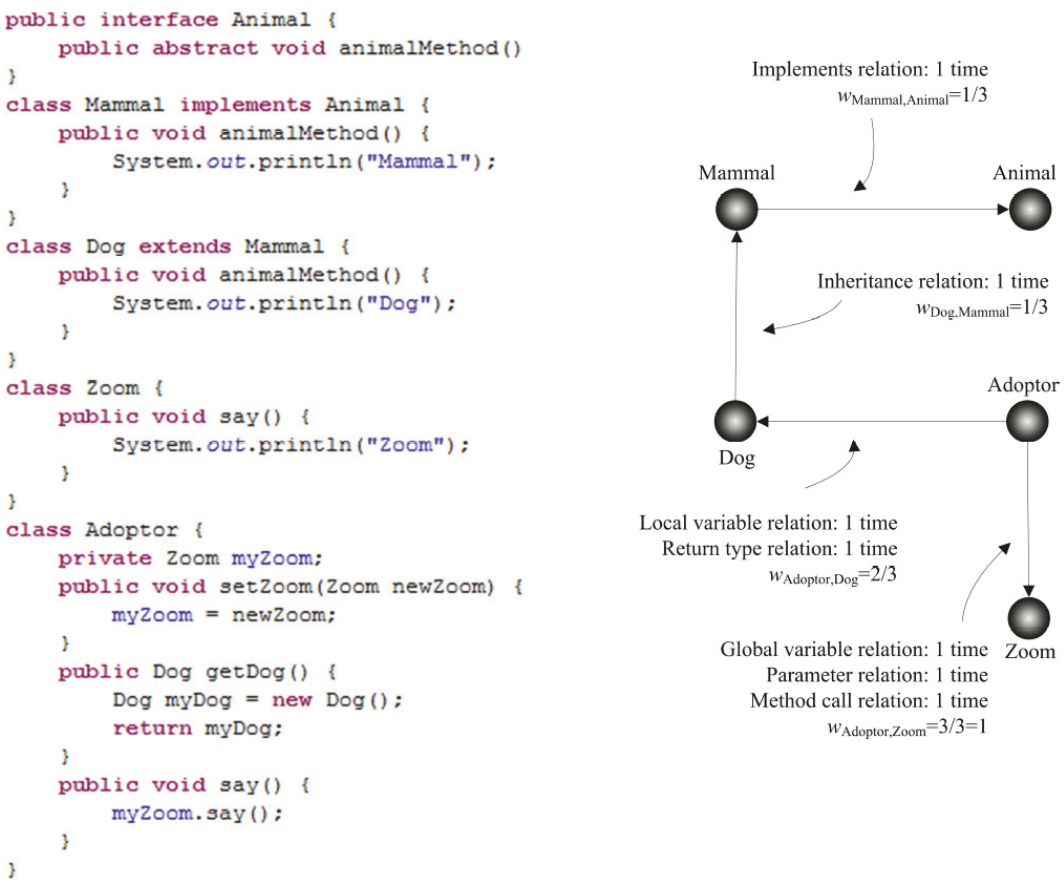
Figure 2: The simple source code segment and its corresponding